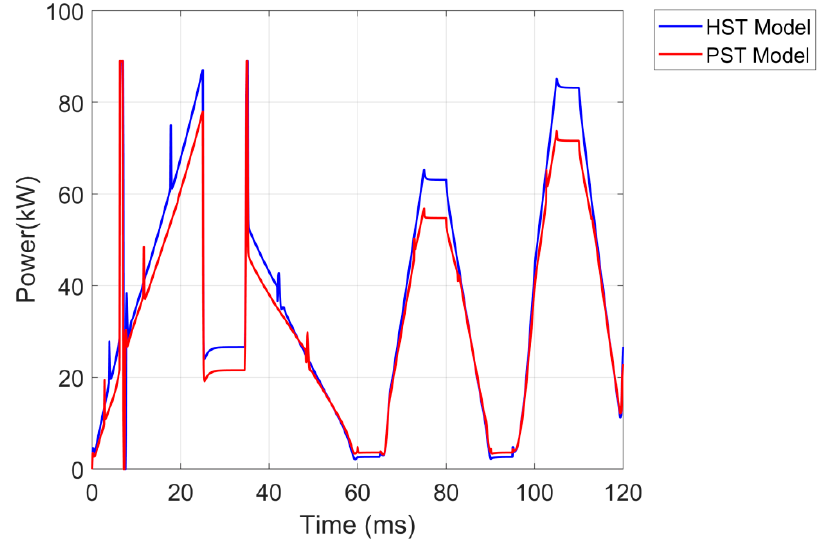
Figure 13. E ff ective power from engine fuel combustion. Figure 13. Effective power from engine fuel combustion.